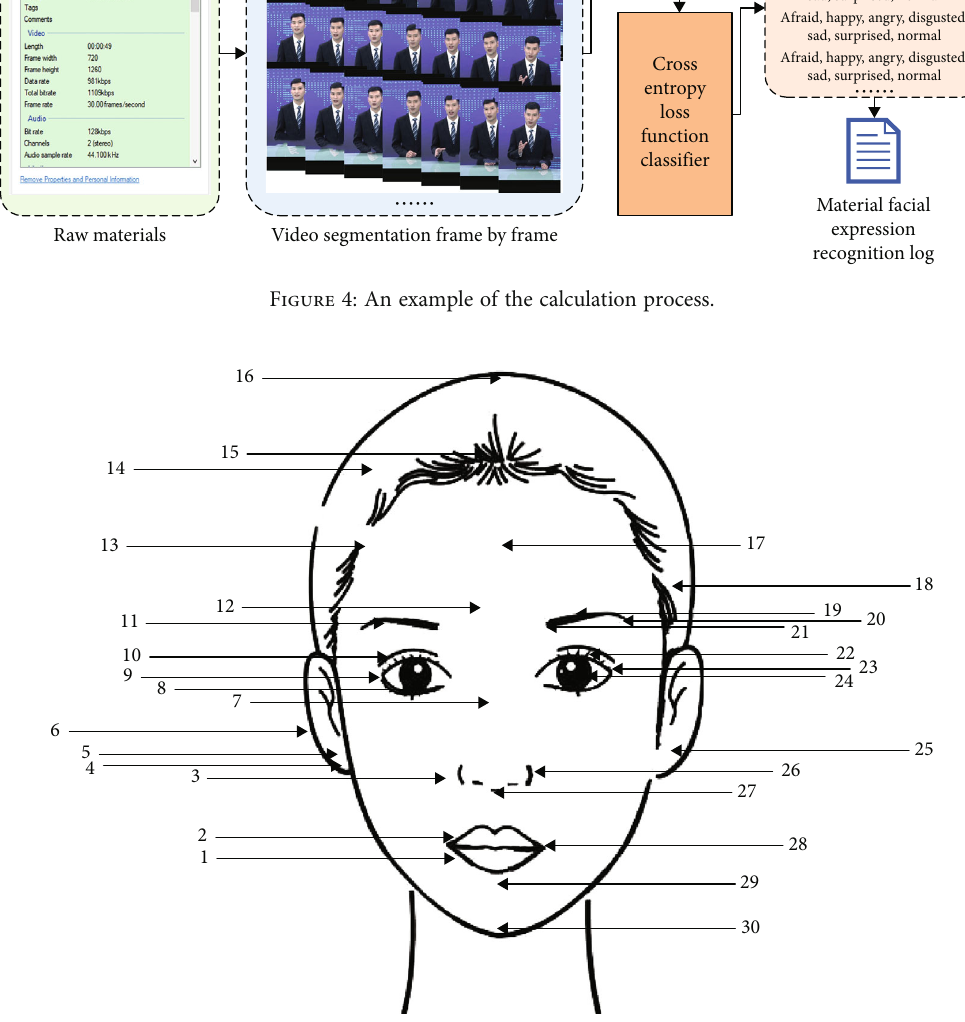
Figure 5: Simple portrait of the fi